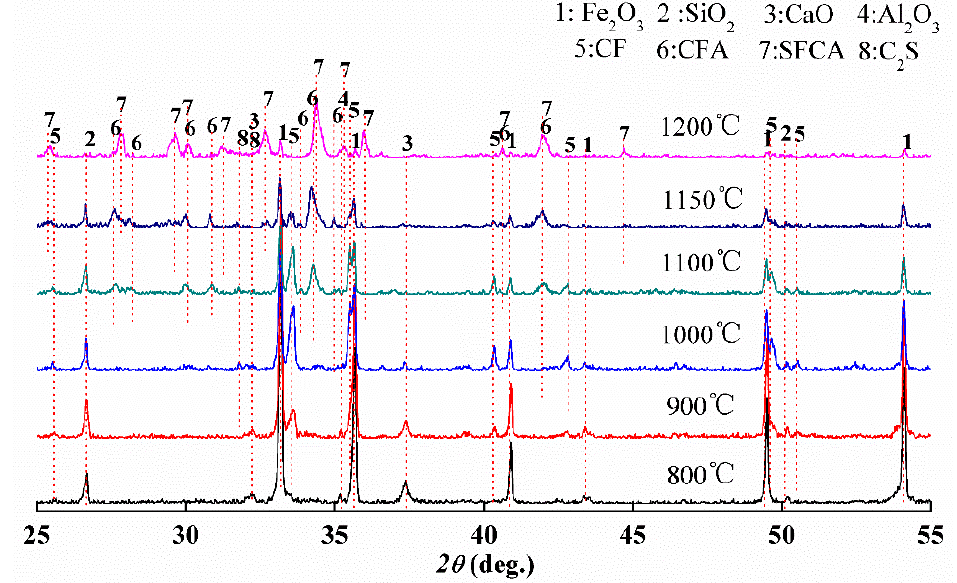
Figure 5. XRD patterns of the sample C sintered at different temperature for 2 h by solid-state reactions.